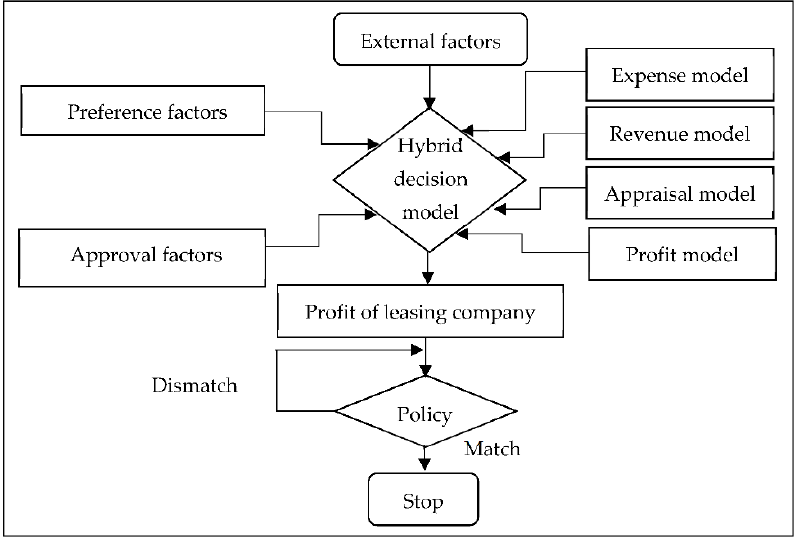
Figure 4. Framework of hybrid decision model.